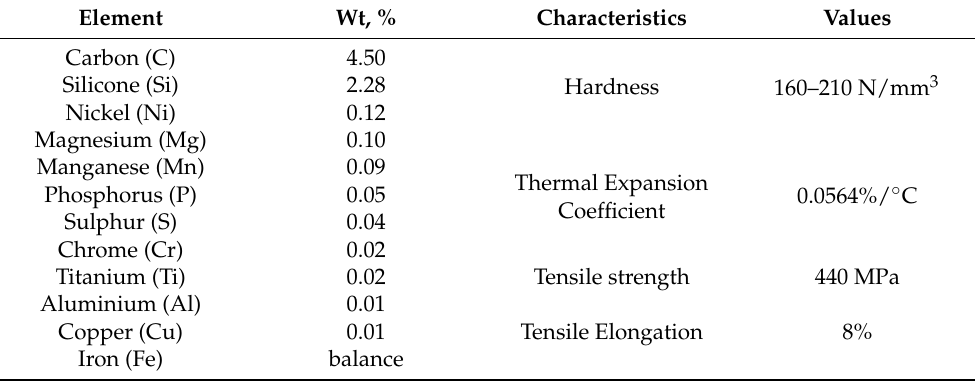
Table 1. The chemical composition and principal characteristics of nodular cast iron used for